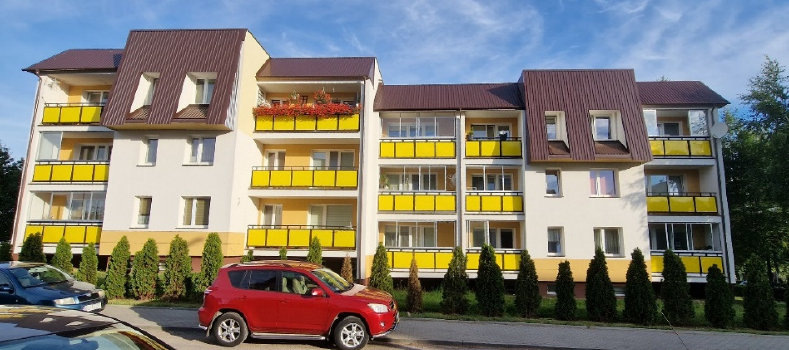
Figure 2. View of a typical building (B3) adopted for the study, made with large-block prefabricated C Ż technology, 3-story, 2-cage [photo taken by authors]. Table 1 shows the basic technical parameters of the 22 buildings analyzed, which are Table 1. Basic technical parameters of the surveyed buildings. labeled